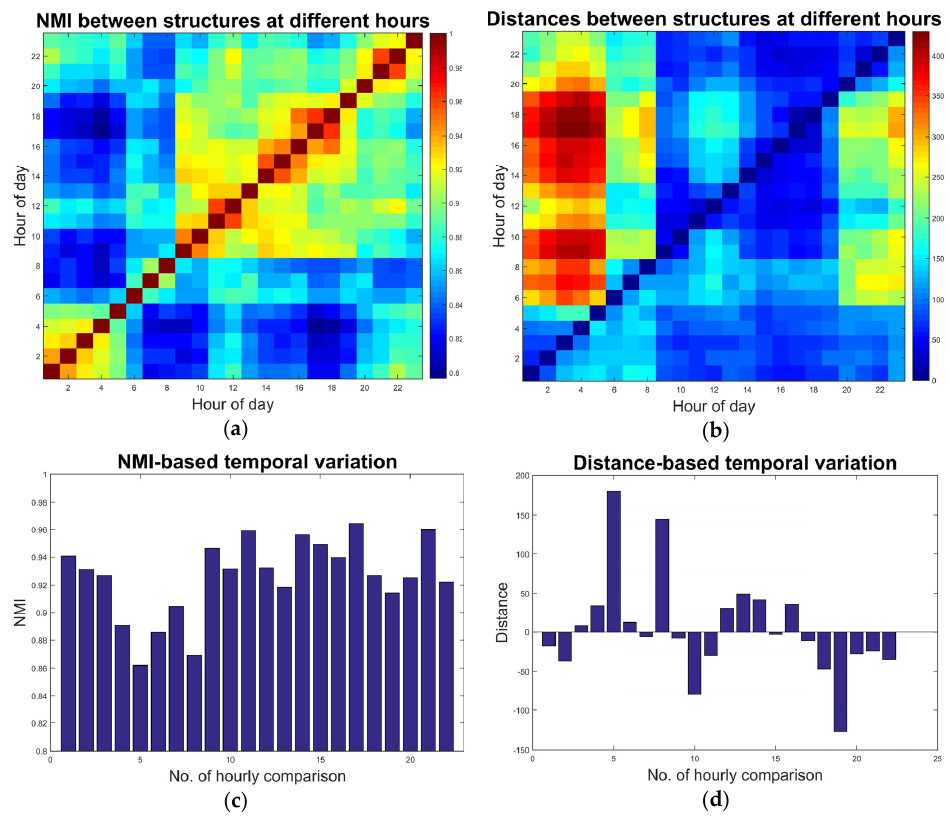
Figure 6. Pair-wise comparisons among structures at different hours by: ( a ) NMI; and ( b ) “split-join” distance; and the temporally successive dynamics by: ( c ) NMI; and ( d ) “split-join” distance.